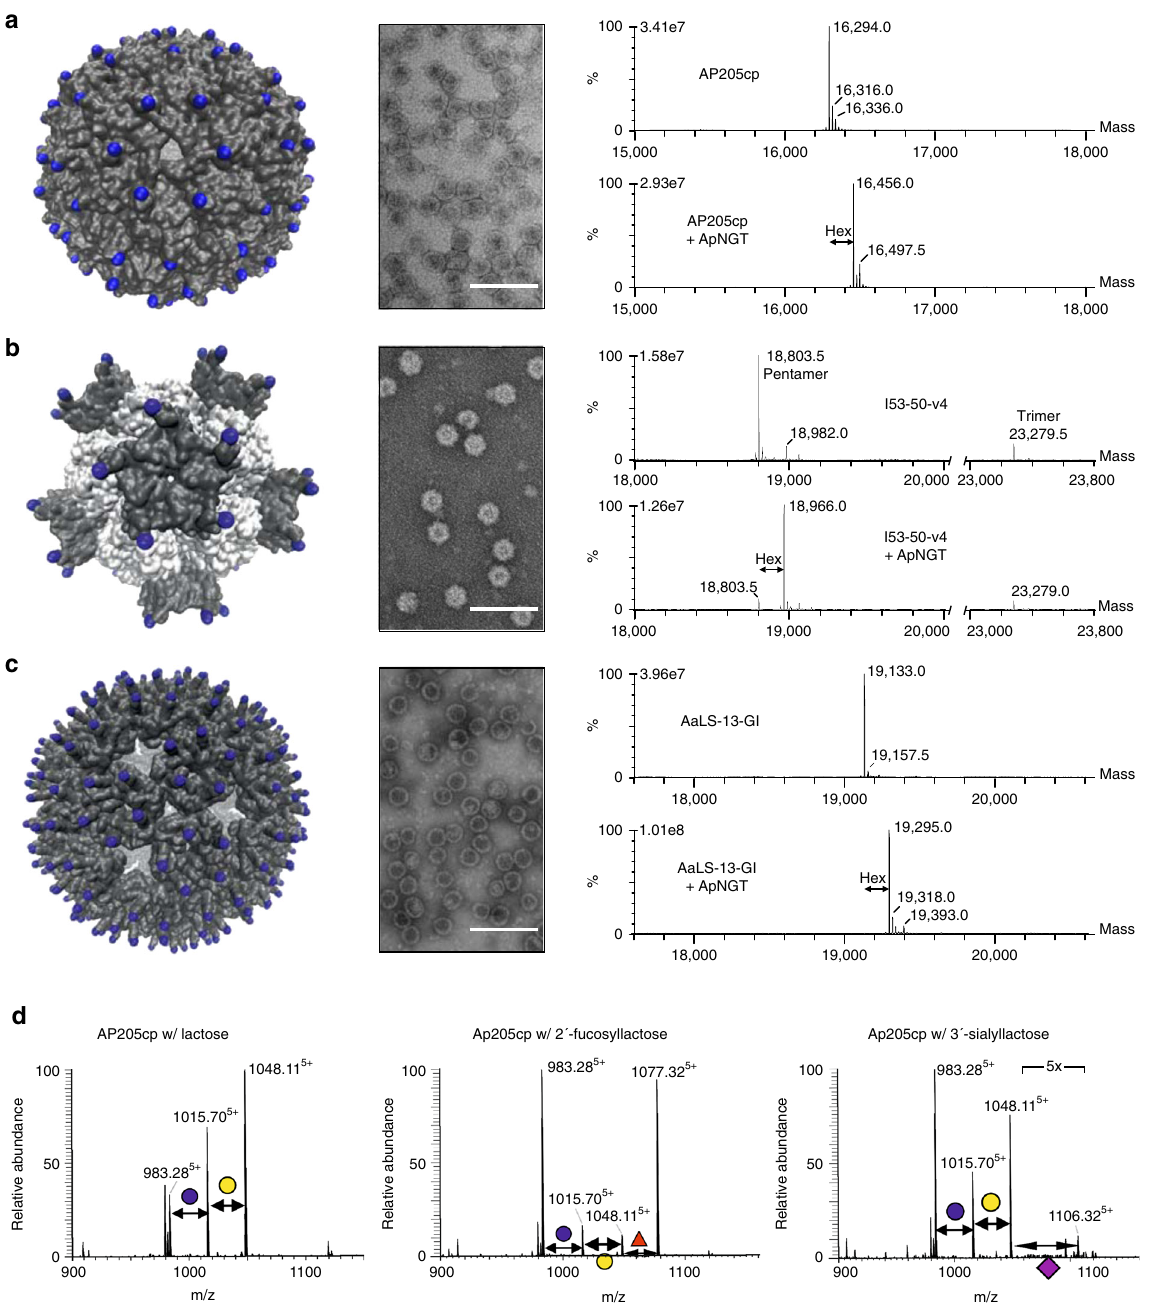
Fig. 3 Glycosylation of megadalton protein assemblies. Glycosylation sites were introduced into surface-exposed regions of three self-assembling protein nano-structures. Each construct was expressed in the absence and presence of the NGT, particles were puri fi ed, and characterized. Glycosylation sites are indicated as blue spheres on the molecular model of each particle; a AP205 VLP, b I53-50-v4, trimer and pentamer subunits are white and gray, respectively, and c AaLS-13. Assembly of particles was assessed by transmission electron microscopy (scale bars represent 100 nm). Glucosylation was assessed by intact protein mass spectrometry, deconvoluted spectra are shown in the right panel. d The AP205 VLP was co-expressed with established pathways for lactose, 2 ′ -fucosyllactose, and 3 ′ -sialyllactose. Modi fi cation of the coat protein (AP205cp) was assessed by nano-LC – MS/MS analysis of tryptic peptides. MS spectra are the sum of all modi fi ed and unmodi fi ed peptides, in the 5 + charge state, with sequence TLFASGNAGLGFLDPTAAIVSS DTTAGSGGAHATA N ATAHATWSHPQFEK (where N is the potential N-glycosylation site). The assigned structures are supported by respective HCD – MS/MS spectra (Supplementary Fig.